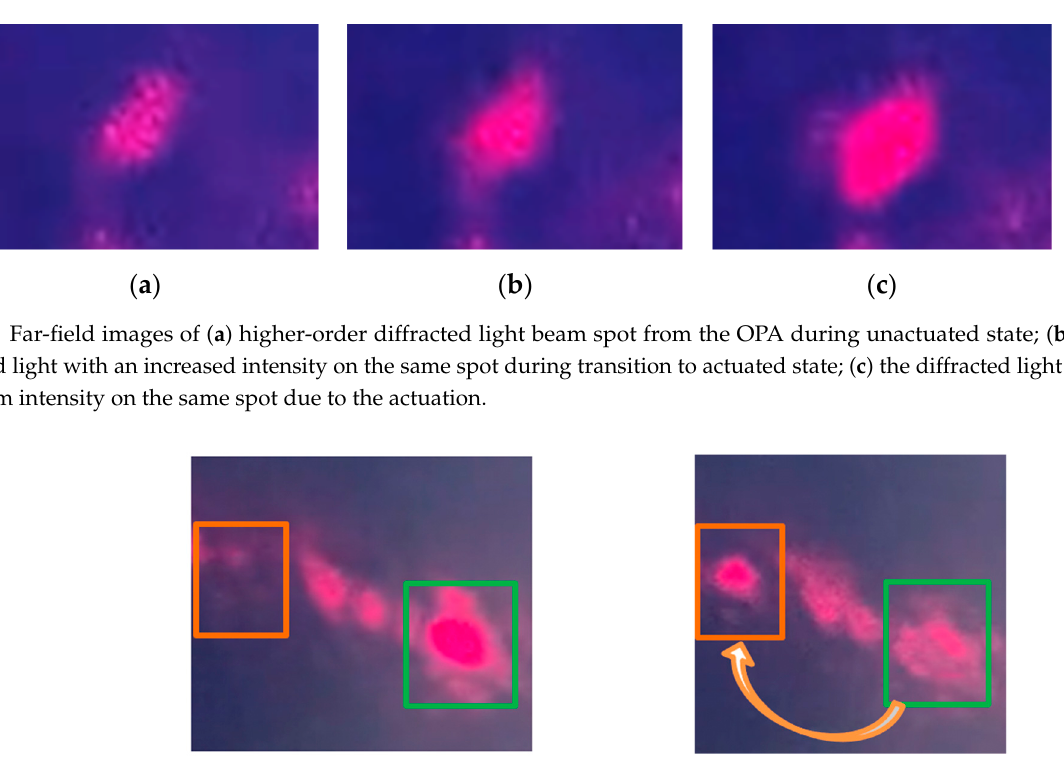
Figure 7. Schematics of various patterns of binary phase shift created by the piston-type OPA device consisting of 24 micromirrors with: ( a ) no phase shift; ( b ) a number of displaced micromirrors per phase period of 1; ( c ) a number of displaced mirrors per phase period of 8.